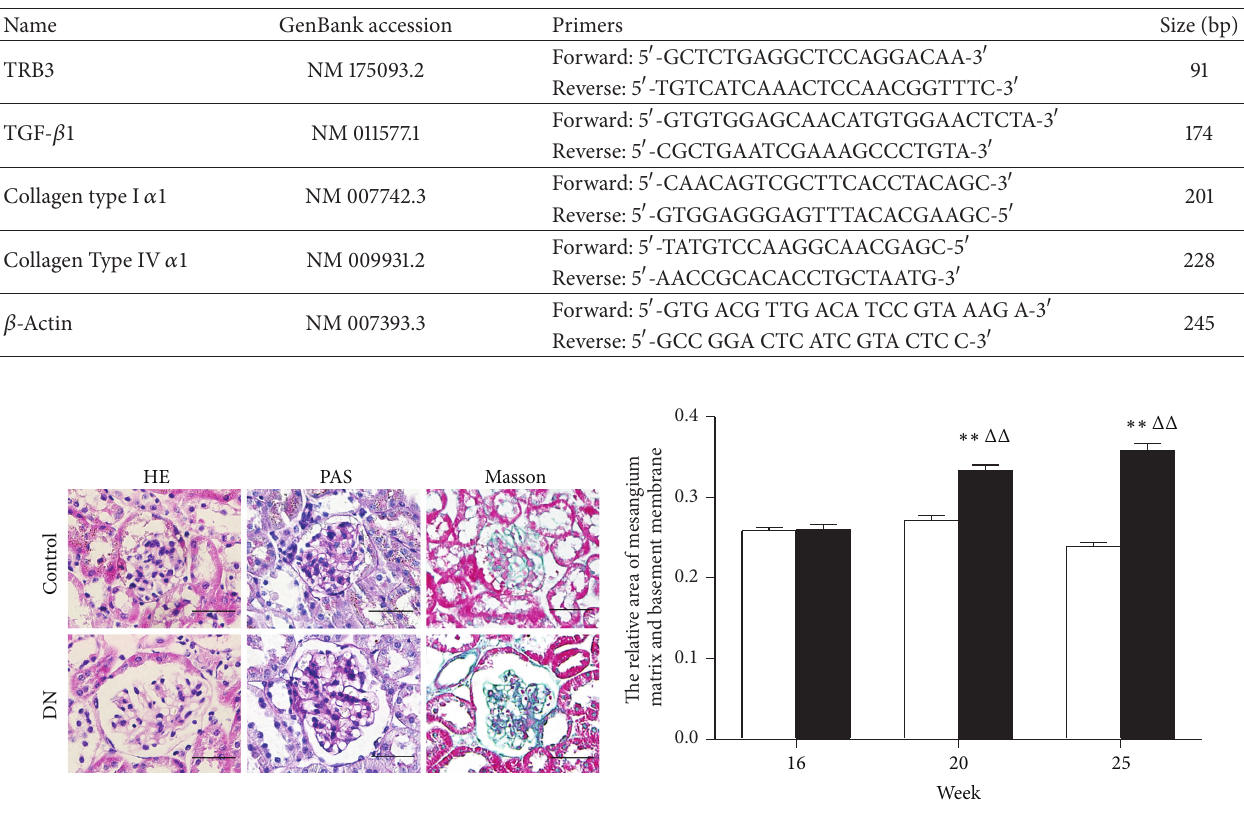
Table 1: Primers used for RT-PCR.